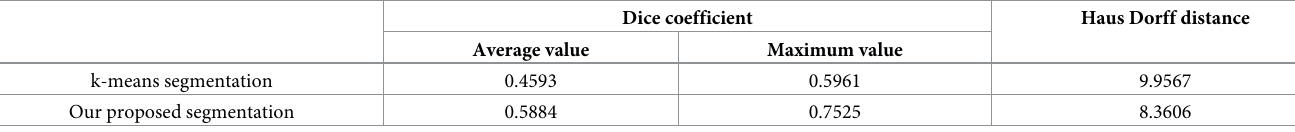
Table 12. Dice coefficient and Haus Dorff distance of segmentation results.